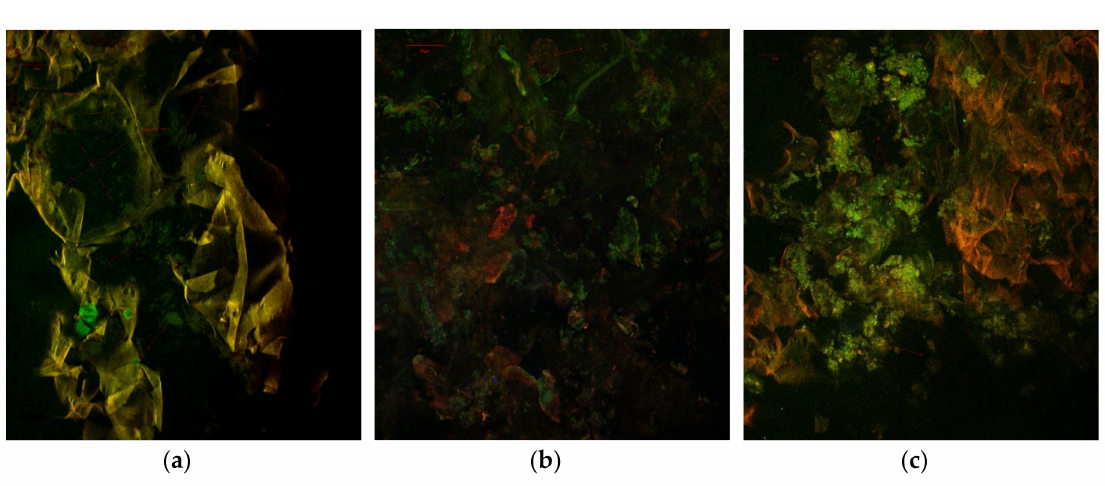
Figure 2. The confocal laser scanning microscopy images for the marmalade samples: ( a ) red beetroot, ( b ) red beetroot and sour cherry and ( c ) sour